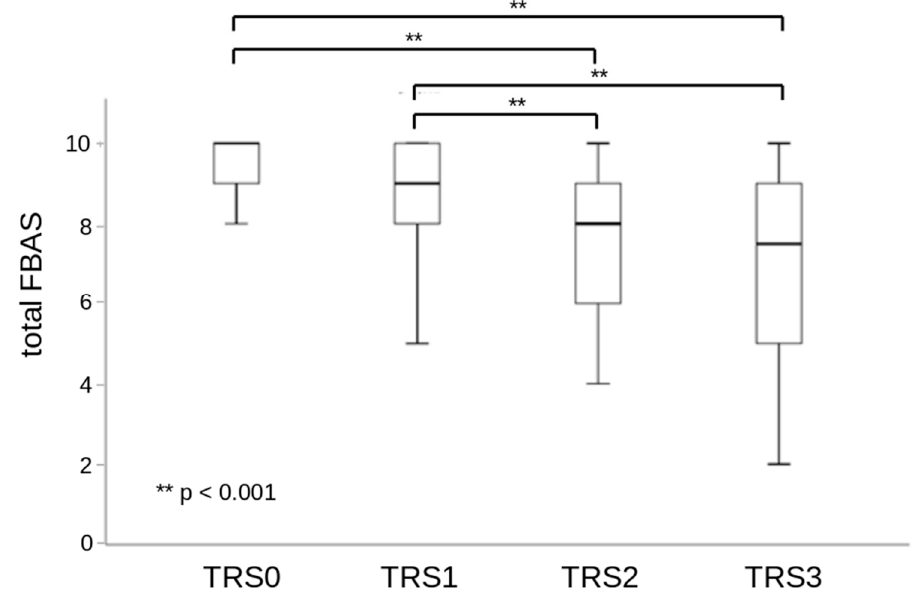
Figure 3. Comparative boxplots of the Functional Bedside Aspiration Screen (FBAS) with the need for specialized swallowing therapy (TRS). TRS0 = no dysphagia, no counseling or diet modification required; TRS1 = education and guidance with regards to the necessary compensatory strategies or diet changes, as needed occasional dysphagia therapy; TRS2 = compensatory strategies or diet changes required, intensive dysphagia therapy, education and guidance; TRS3 = profound diet changes required, full or partial tube feeding, intensive dysphagia therapy, education and guidance. The significant correlation between TRS and PAS as well as FOIS is shown in Table 4. Table 4. Correlations between TRS and PAS and FOIS. Correlations TRS Pearson Correlation 0.687 PAS